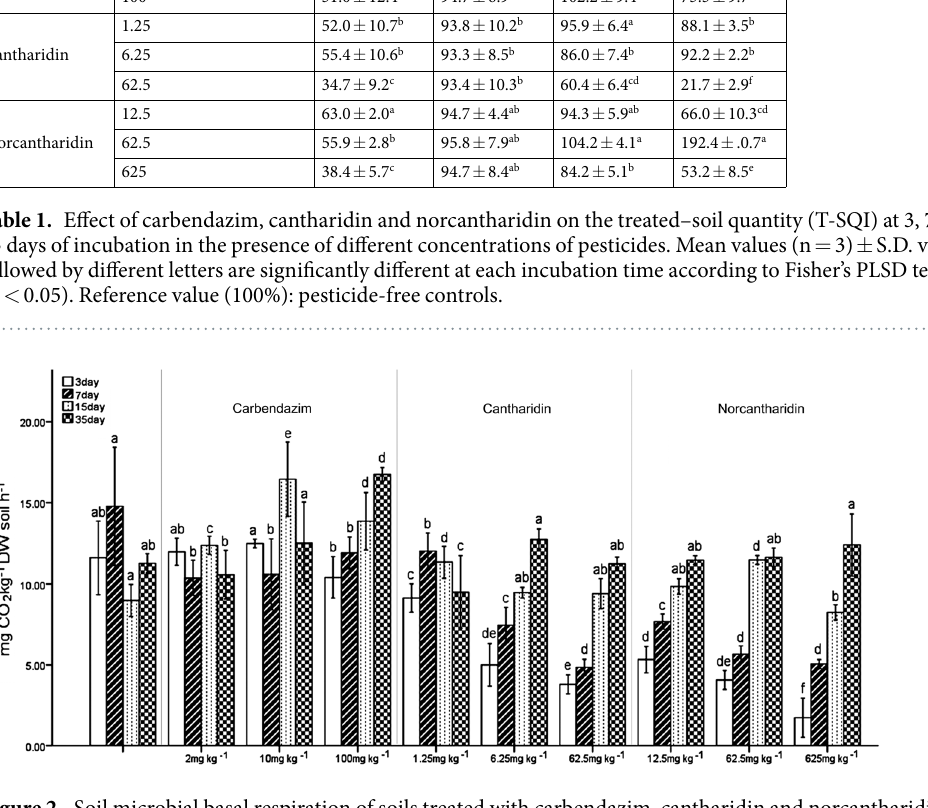
Figure 2. Soil microbial basal respiration of soils treated with carbendazim, cantharidin and norcantharidin during the 35-day incubation (mean ± S.D.). Letters near data points indicate a significant difference between the pesticide treatment and